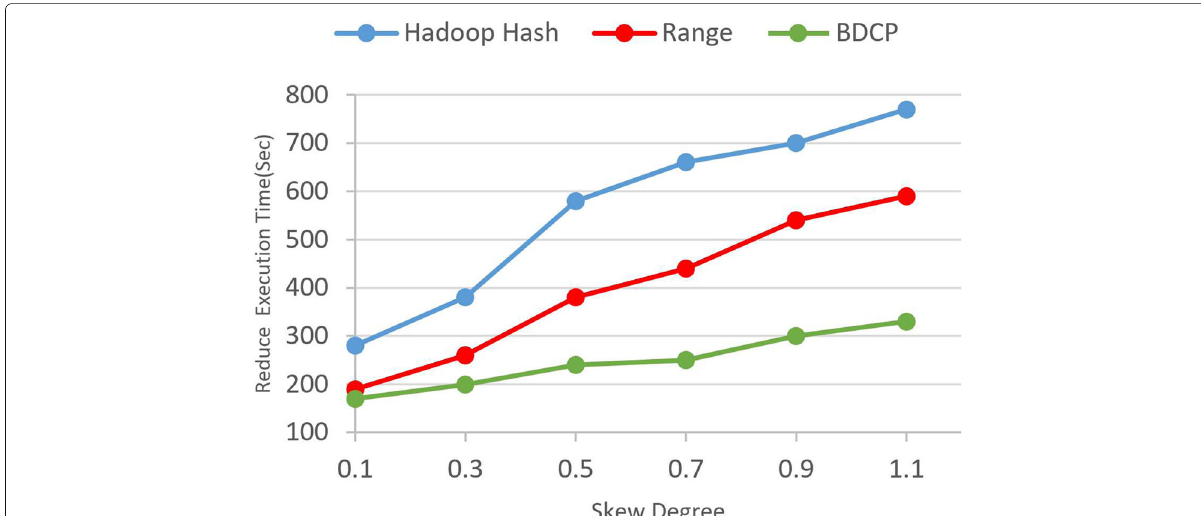
Fig. 7 Word count job on a file of size 6 GB, and 0.1 to 1.1 skew degree